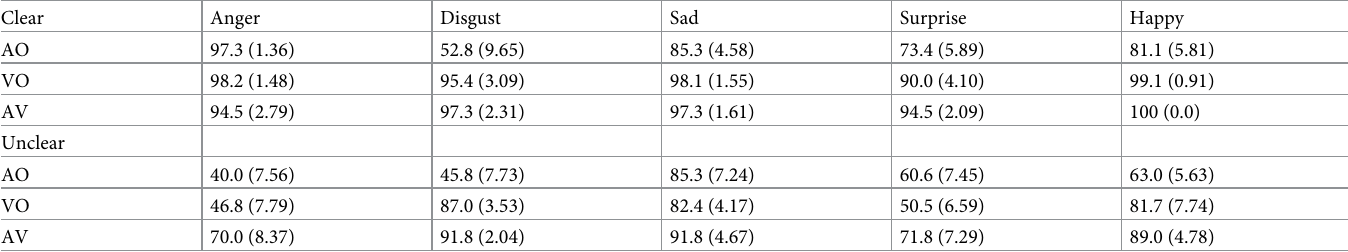
Table 1. Mean percent correct scores (Standard Error, SE) for the clear and unclear presenters across presentation modality and emotion (data from